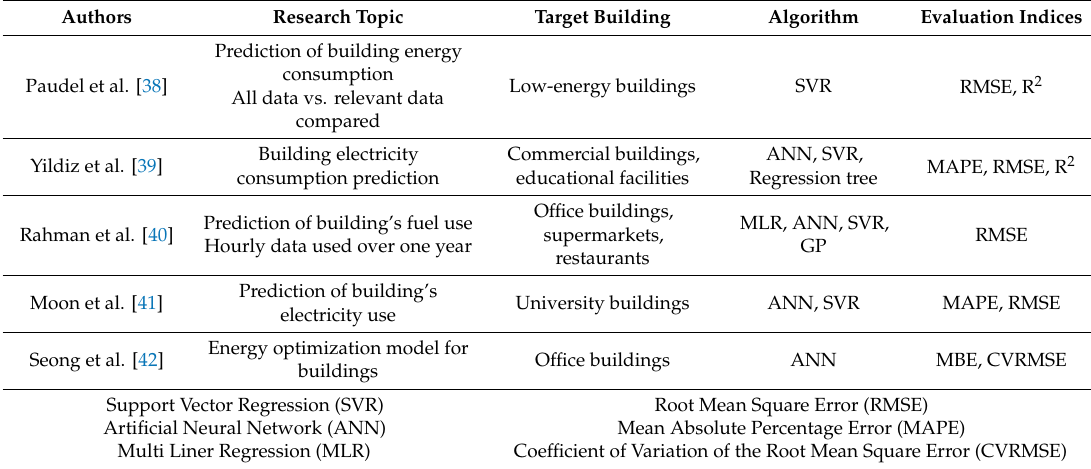
Table 2. Prediction of building energy consumption through machine learning.